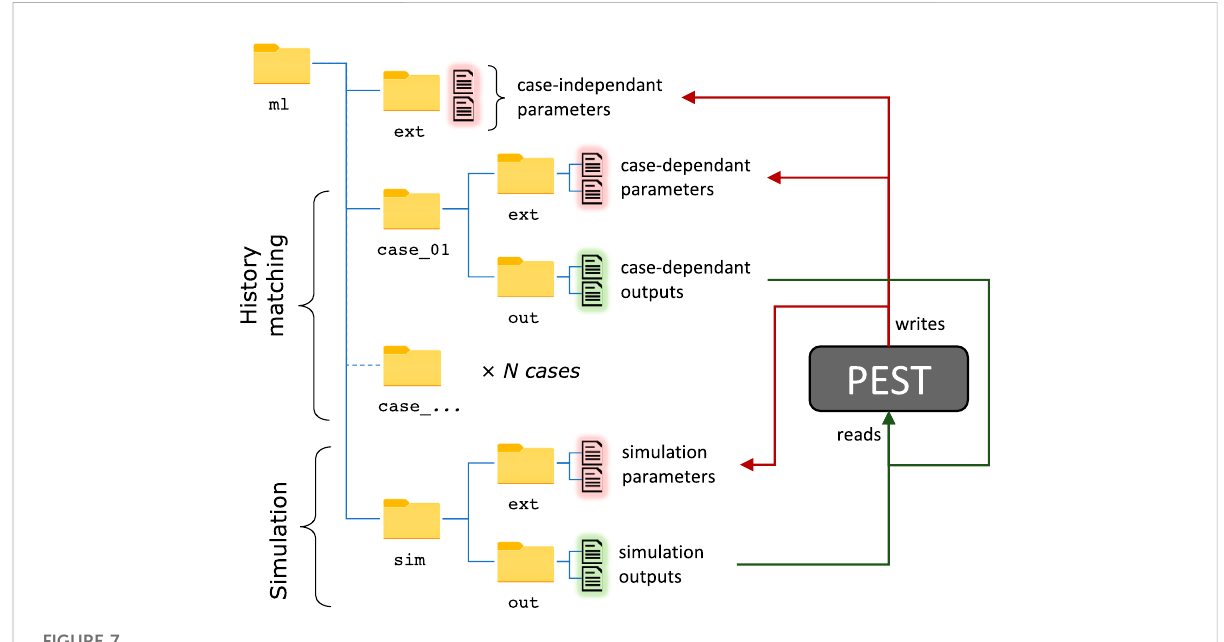
FIGURE 7 Directory tree structure used for parameter estimation and optimization work fl